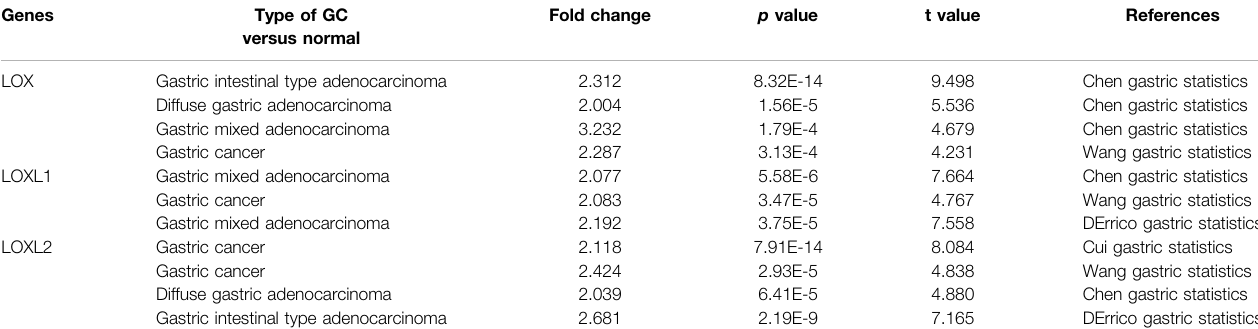
TABLE1 | Remarkable changes of LOX family expression in transcription level between GC and normal gastric tissues (ONCOMINE). Genes